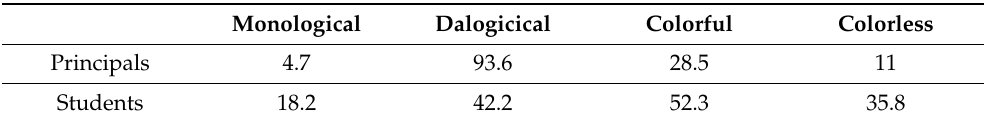
Table 5. Preferred Catholic School Identity (in %): School Principals and Students (secondary Catholic